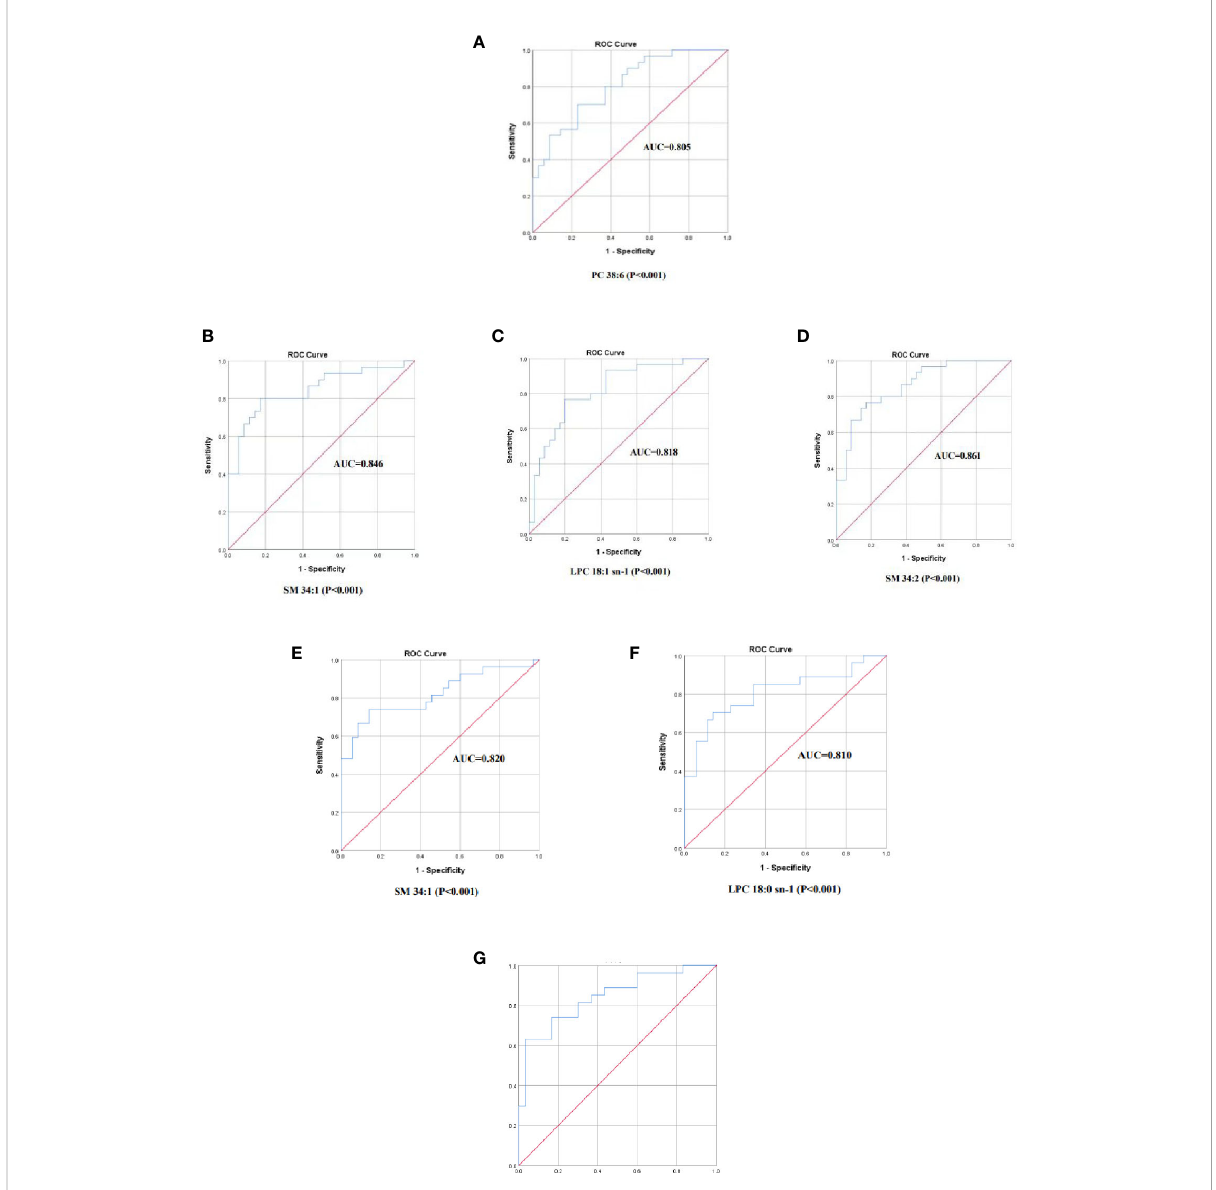
FIGURE 6 The ROC curve of selected metabolomics. (A) PC 38:6, AUC=0.805. (B) SM 34:1, AUC=0.846. (C) LPC 18:1 sn-1, AUC=0.818. (D) SM34:2, AUC=0.861. (E) SM 34:1, AUC=0.820. (F) LPC 18:0 sn-1, AUC=0.810. (G) X=0.379(LPC 18:0 sn-1)+0.395(FFA 18:0)-1.537(PC 32:2)-8.246, AUC =0.843,